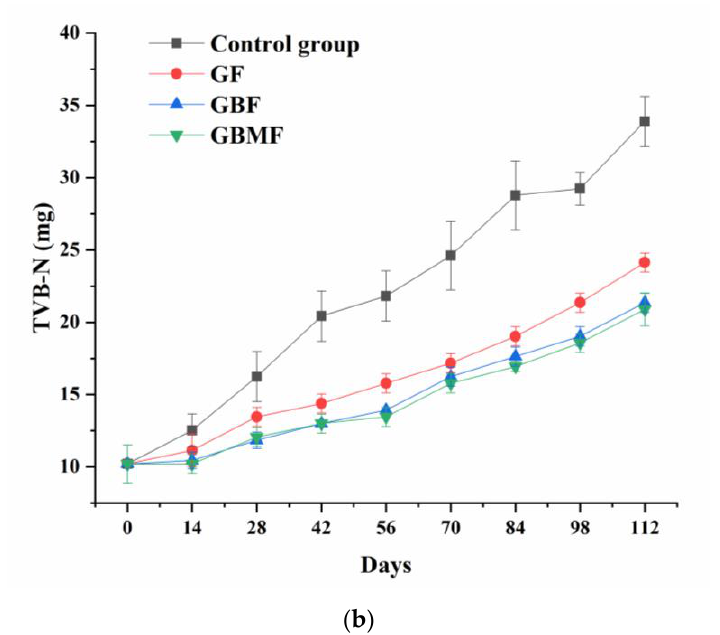
Figure 7. Changes in the TVB-N content of preserved egg white ( a ) and yolk ( b ) coated with different films.